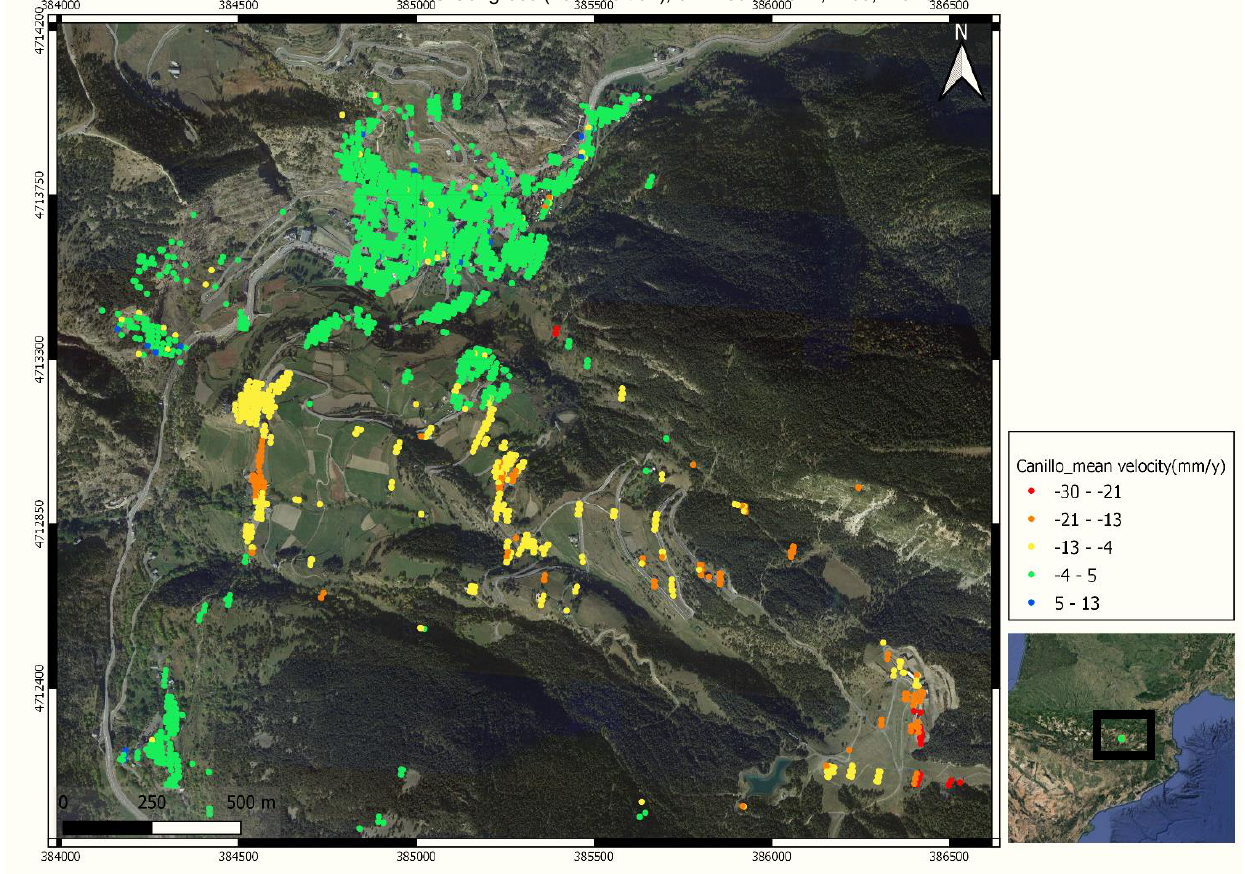
Figure 1. A plot of Mean velocity map in Canillo, in Andorra. Deformation velocity varies between -30 and 13 (mm/yr) from 2015 to